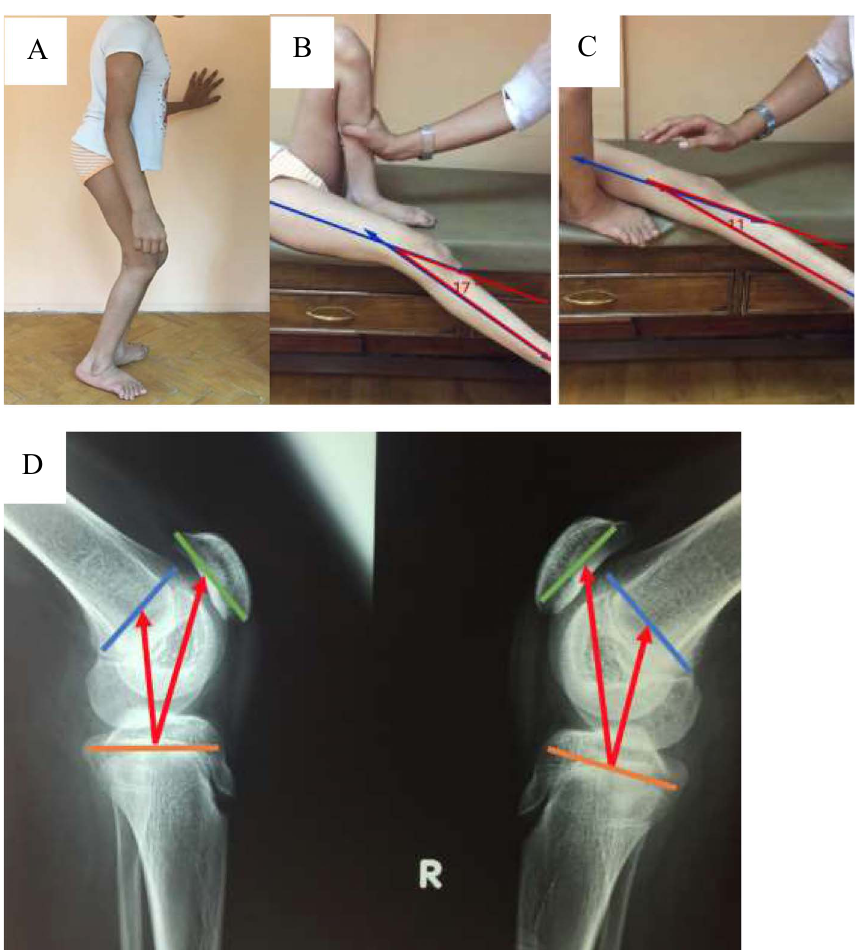
Figure 3. (A) Preoperative clinical presentation of a 13-year-old female with spastic diplegia and crouching gait, GMFCS II. (B) and (C) right and left extension lag of 17 (cid:3) and 11 (cid:3) , respectively. (D) Preoperative Koshino index left 1.5 and right 1.36. (E) and (F) Clinical picture 6 months after bilateral patellar tendon plication, bilateral iliopsoas tendinous release, left rectus femoris intramuscular lengthening and bilateral double column osteotomy. G. and H. Extension lag 5 (cid:3) right and 0 (cid:3) left knee. (I) and (J) Koshino index right knee 1 and left knee